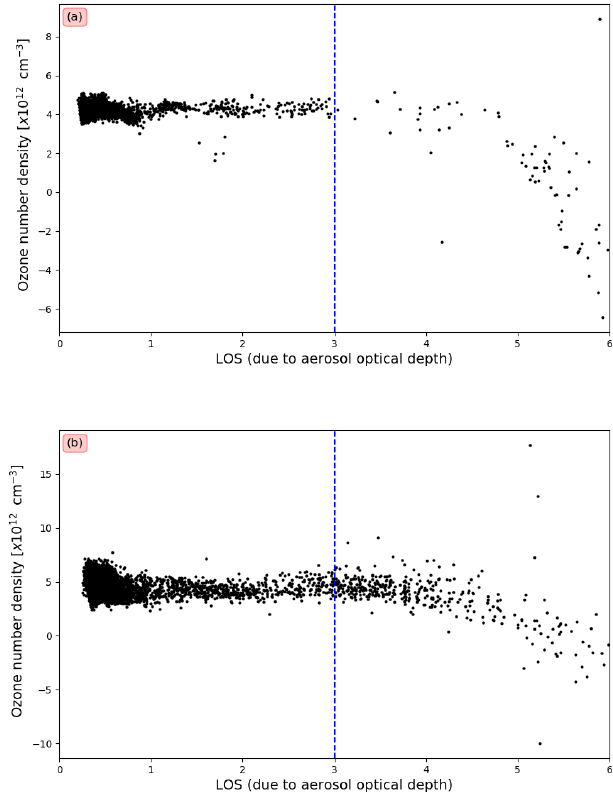
Figure 7. Ozone number density versus LOS optical depth due to aerosol at (a) 24km between 5 and 15 ◦ S and (b) 21km between 35 and 45 ◦